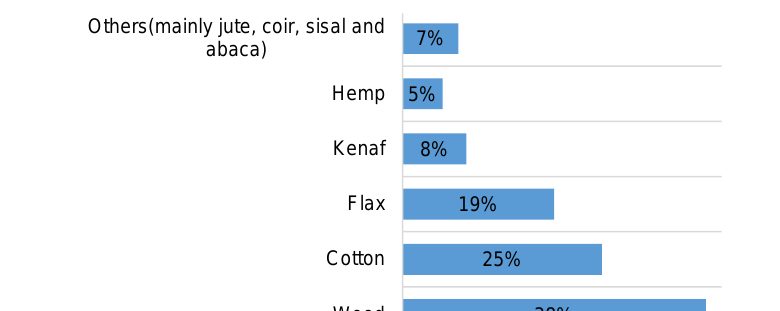
Table 8. Applications of natural fibres in automotive industry. Adapted from: [43,91,96 – 99]. Natural Fibres Component Description Reference(s) Other Constituents Carrier for covered door panels, covered components for instrument panels, covered inserts, carrier for hard Bast fibres (flax, hemp, kenaf, jute, sisal, etc.)